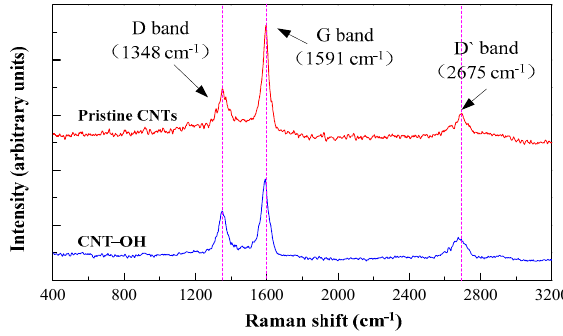
Figure 4. Raman spectra from carbon nanotubes.